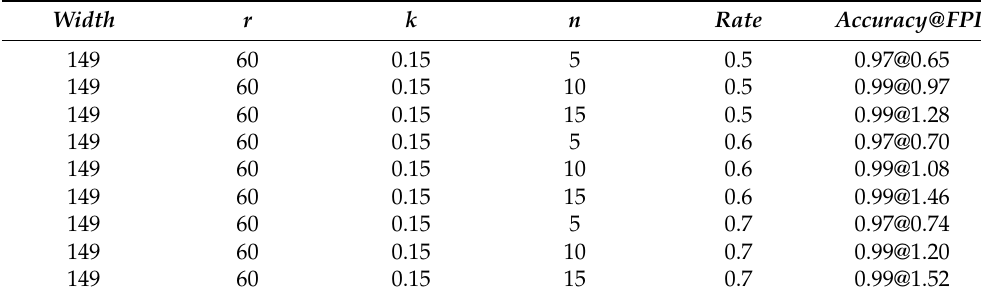
Table 12. Performance of the proposed GFNet framework on INbreast with false positive reduction and